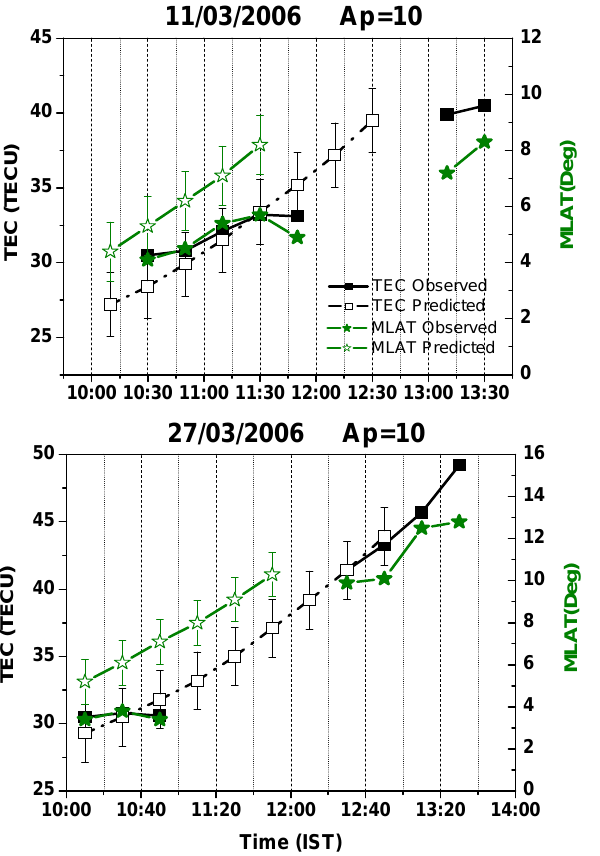
Fig. 6. Same as Fig. 5 but for two moderately disturbed days during March 2006.